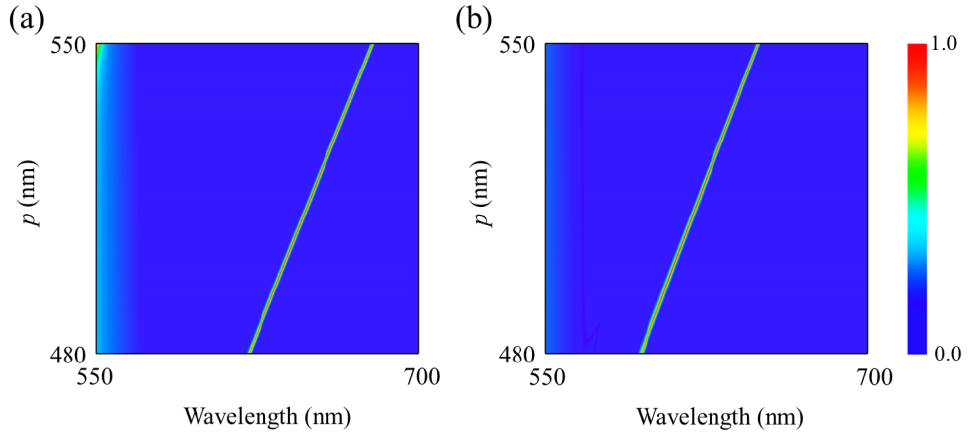
Figure 4. Absorption spectra of the proposed structure as a function of wavelength and period p for polarizations along ( a ) [100] and ( b ) [001] crystalline directions of α -MoO 3 . h = 300 nm, w = 40 nm, and t = 105 nm.